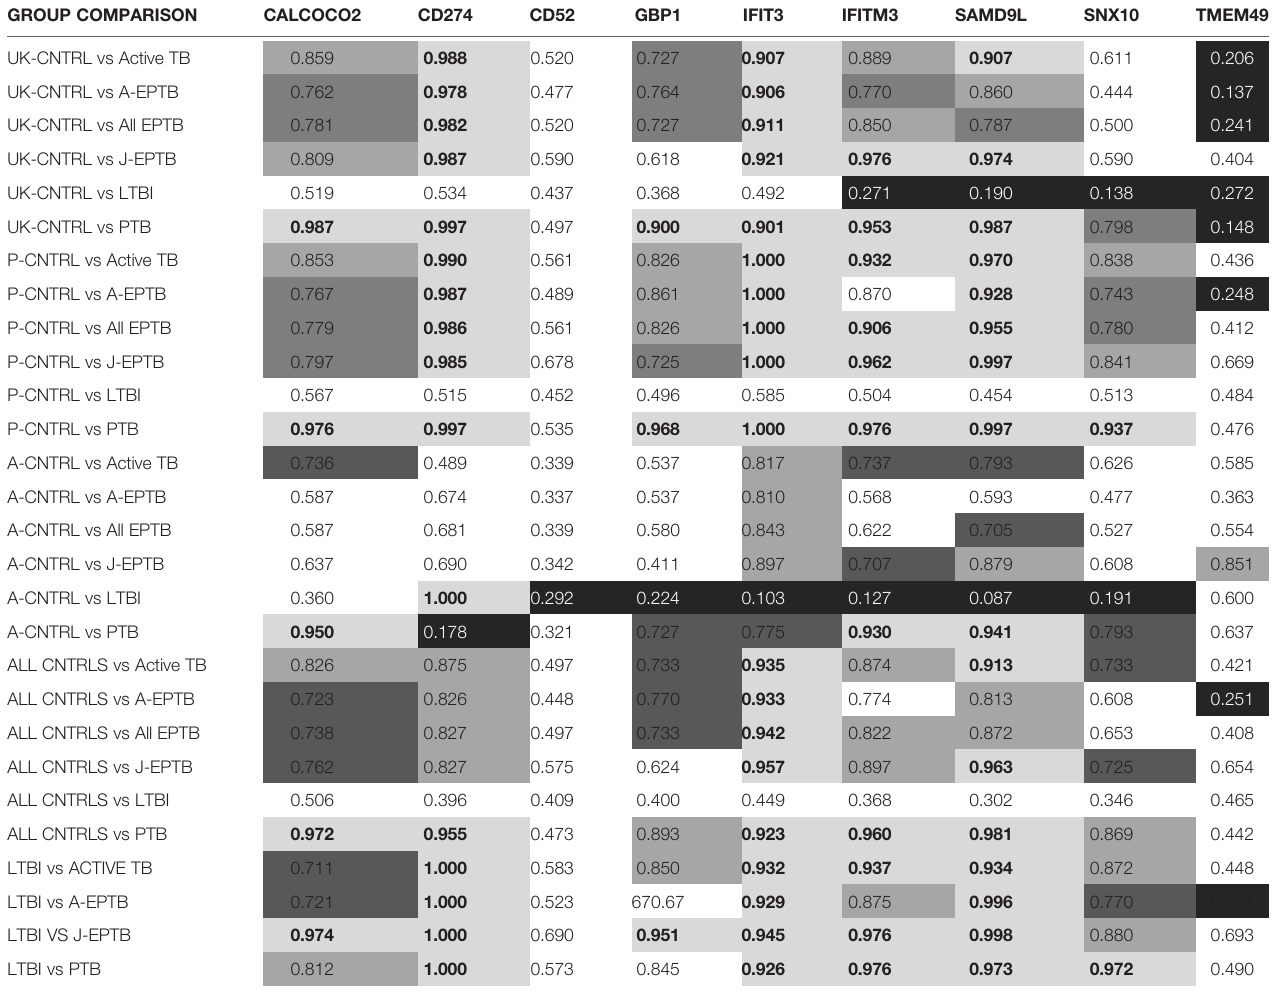
TABLE 3 | Summary of ROC curve values for biomarker expression for all control and TB disease group combinations ROC curve value ≥ 0.9, ROC curve value ≥